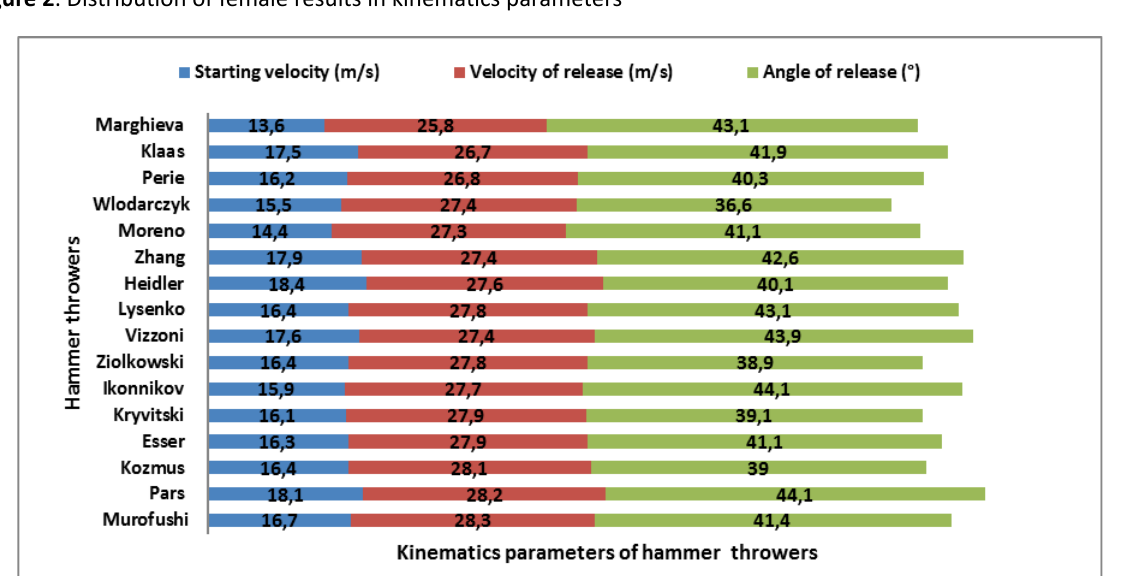
Figure 2 . Distribution of female results in kinematics parameters